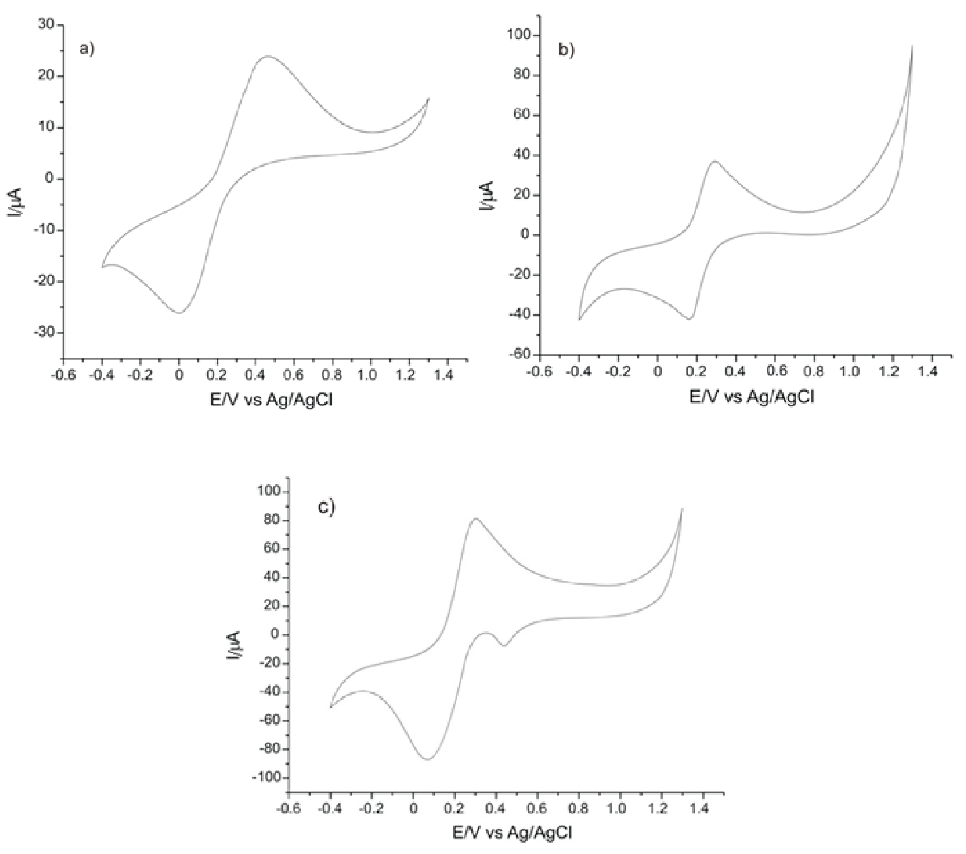
Figure 2. The cyclic voltammograms (CVs) of ( a ) C-SPEs, ( b ) GPH-SPE, and ( c ) GPH-GNP-SPE im-